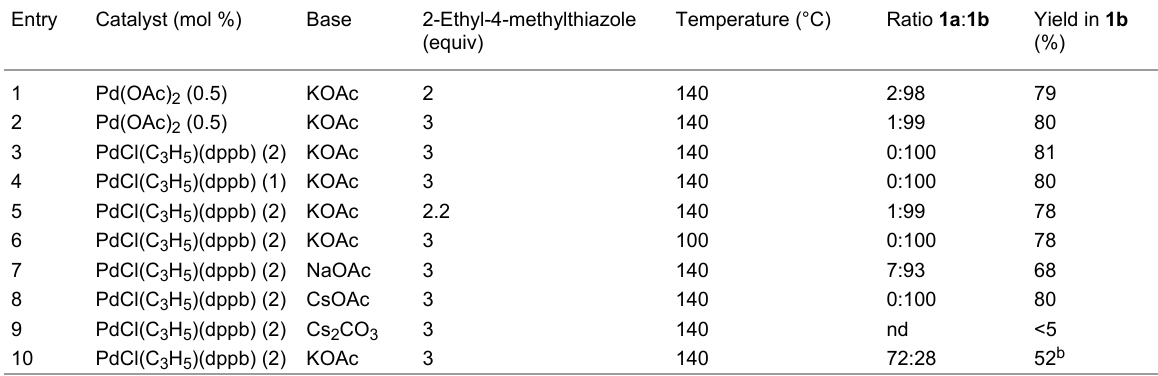
Table 1: Influence of the reaction conditions for palladium-catalyzed direct arylation using 2,5-dibromothiophene and 2-ethyl-4-methylthiazole as coupling partners (Scheme 1).